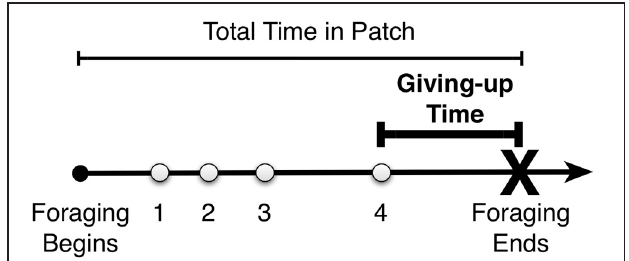
FIGURE 1 | Example time line of foraging in a patch. The participant decides to leave the patch some time after finding the last of four items—the giving-up time.